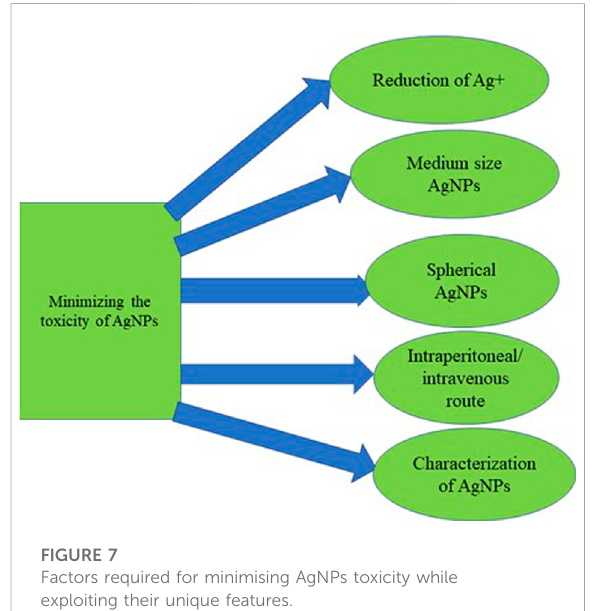
FIGURE 7 Factors required for minimising AgNPs toxicity while exploiting their unique